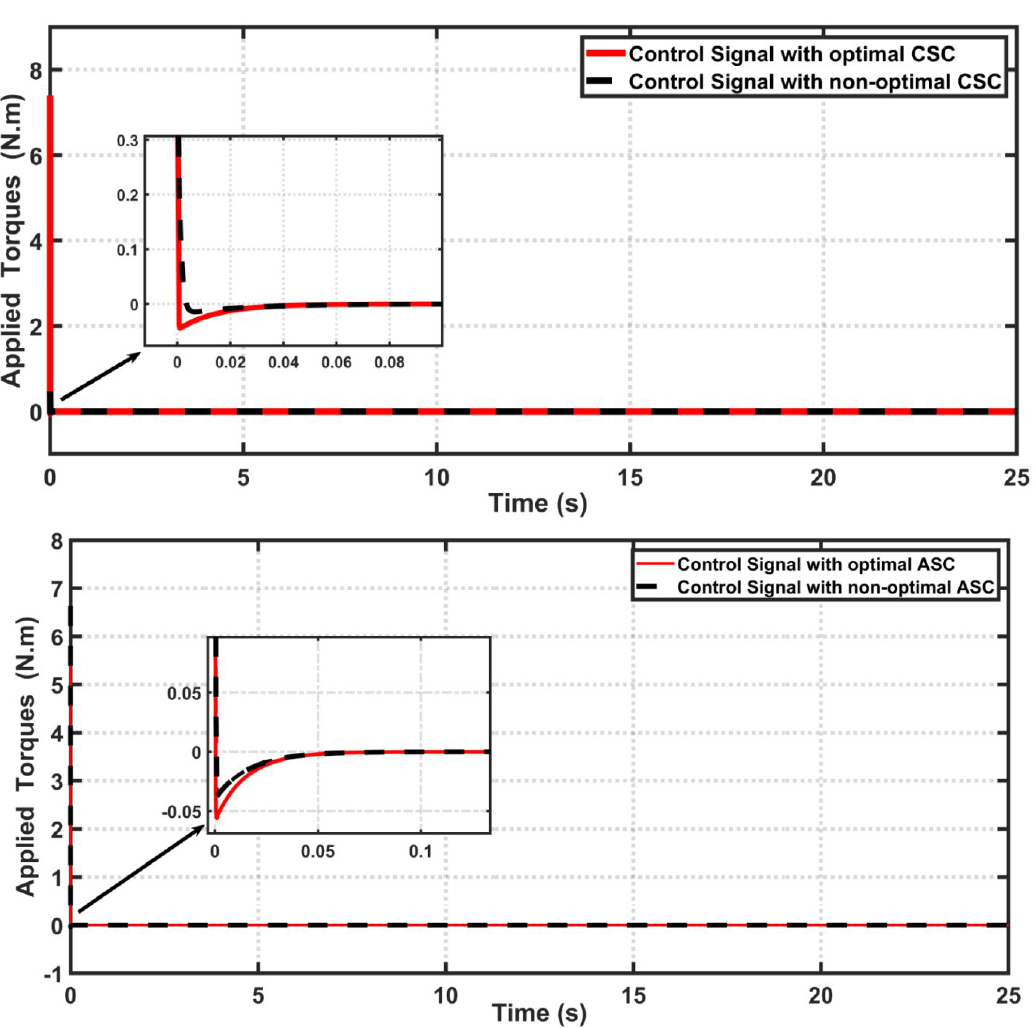
Figure 10. The velocity responses for optimal and non-optimal ASCs.